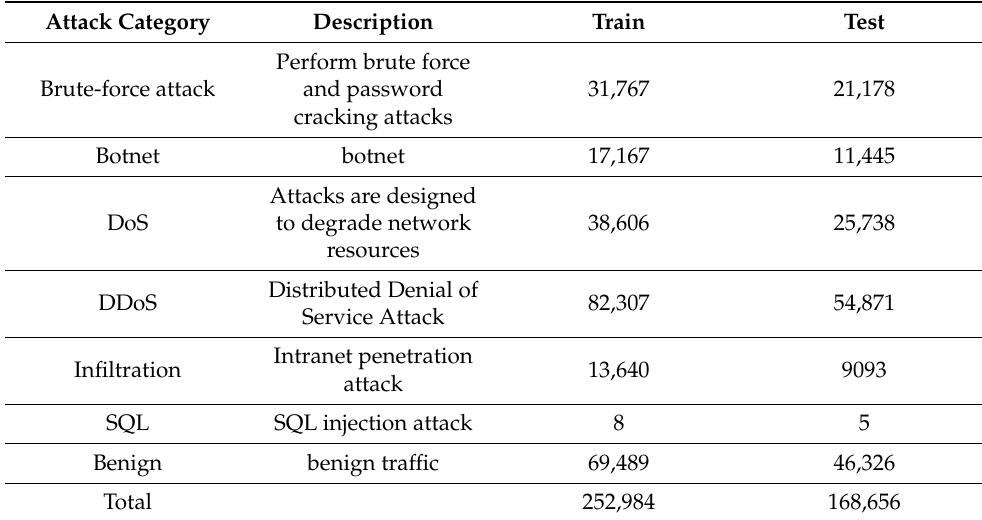
Table 4. Composition of CICIDS2018